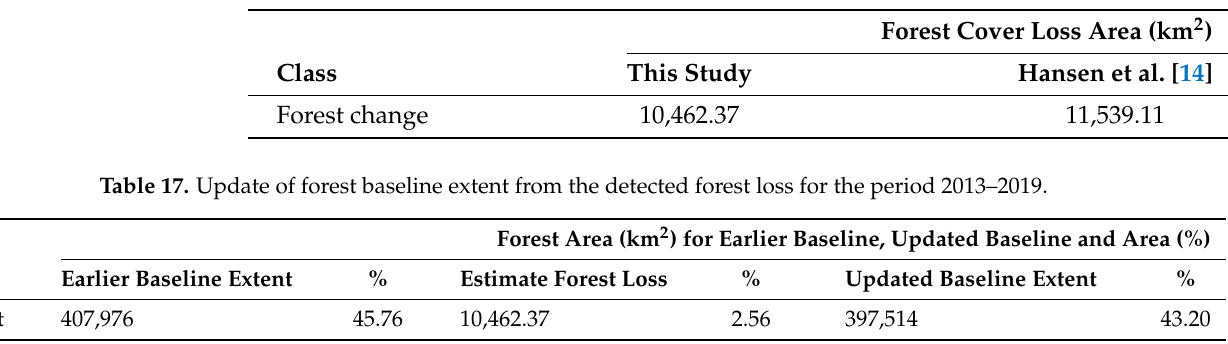
Table 16. Forest loss extent comparison with Hansen et al. [14] version 1.7 for the period 2013–2019.